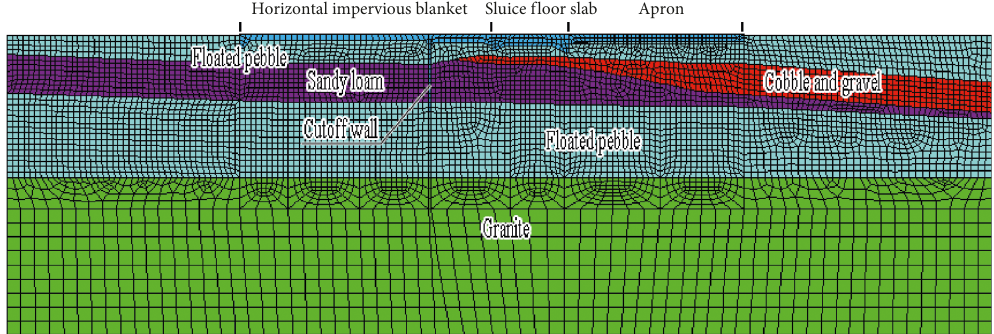
Figure 14: Finite element mesh for 2# sluice